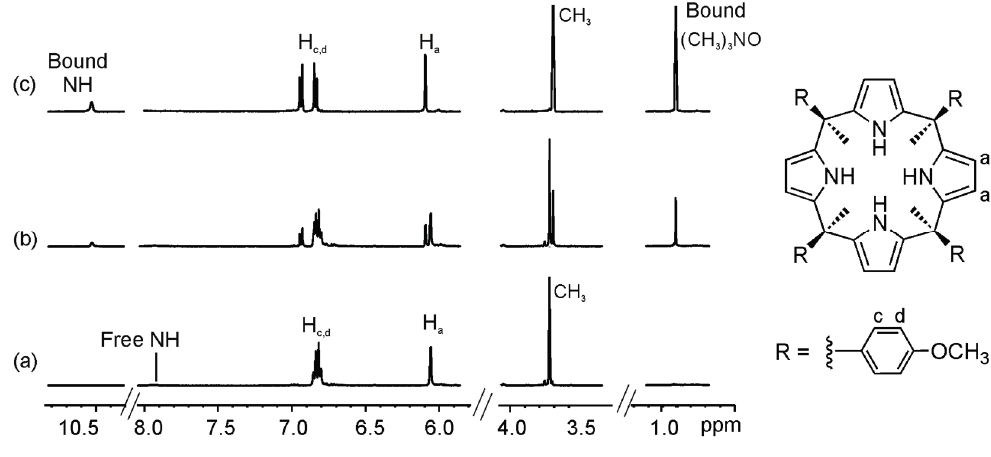
Figure 6. Selected regions of the 1 H-NMR spectra of a CD 3 CN solution of calix[4]pyrrole 1e with 0 eq ( a ); 0.4 eq ( b ); and 1 eq ( c ) of 2a